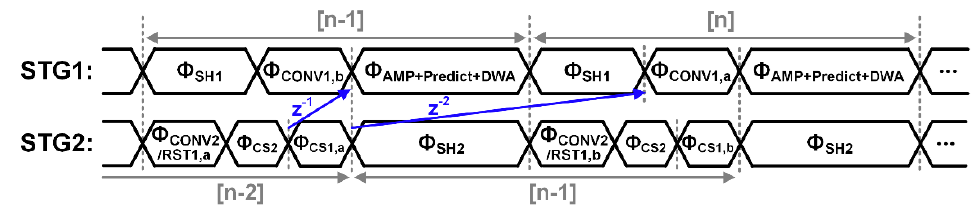
Figure 7. Final timing diagram of proposed structure without any delay.